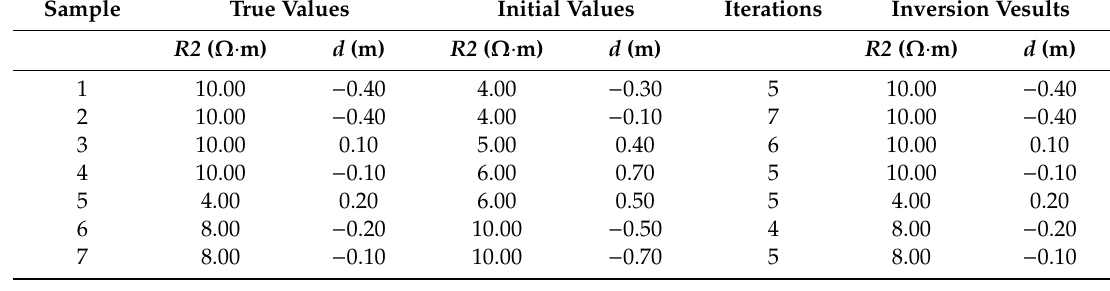
Table 2. Results of two-parameter inversion in the two-layer formation model.